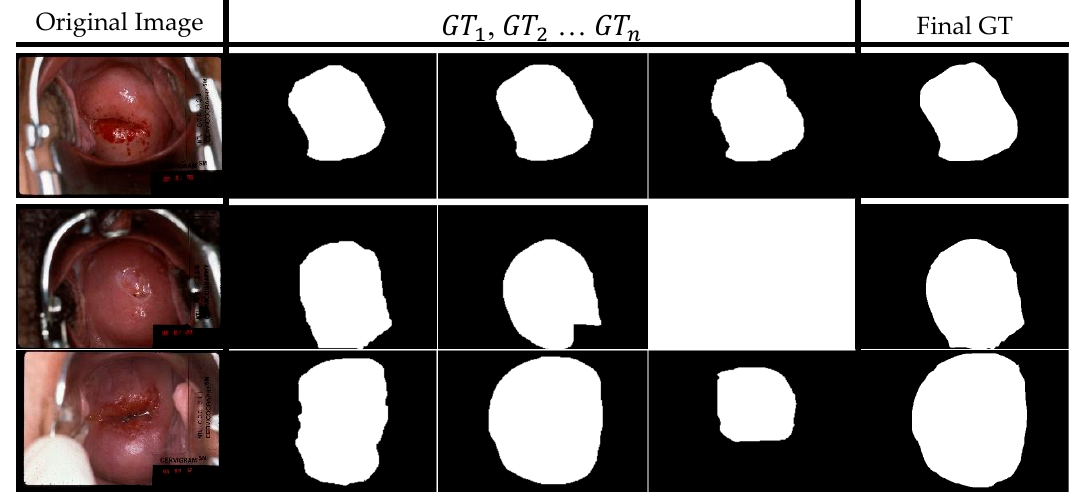
Figure 1. Atypical Squamous Cells of Undetermined Significance/Low-grade Squamous Intraepithelial Lesion (ASCUS/LSIL) Triage Study (ALTS) dataset image examples (Original Image), the samples of experts’ annotations ( GT 1 – GT n ) and the final ground truth (Final GT), the white blobs denote the cervix region. Note that the 2nd row image is labeled by 2 experts with only 2 annotation masks, so the 3rd column is blank. The 1st and 3rd row images have 3 or more than 3 (not shown) annotation masks. The “Final GT” is decided as the union of all the available masks of that image.